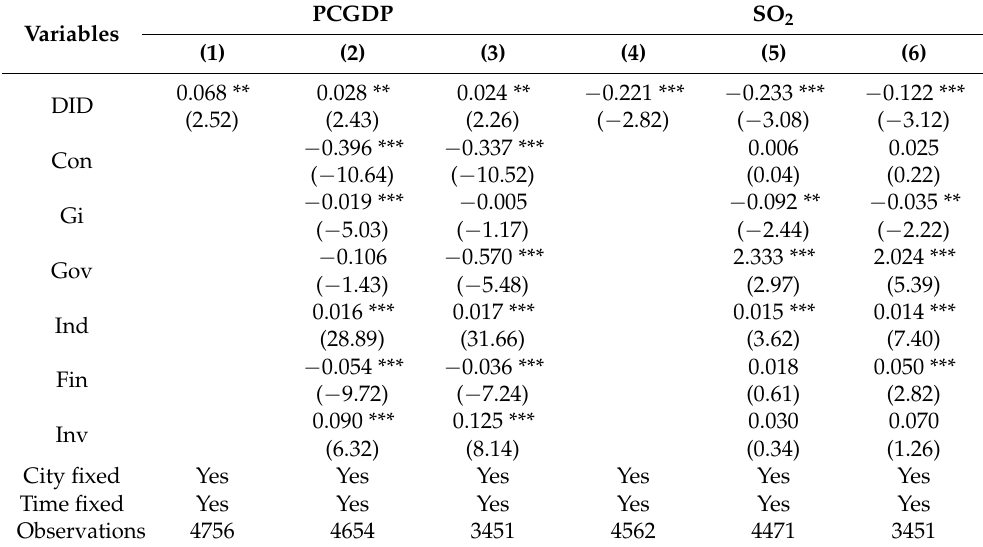
Table 2. Baseline regressive